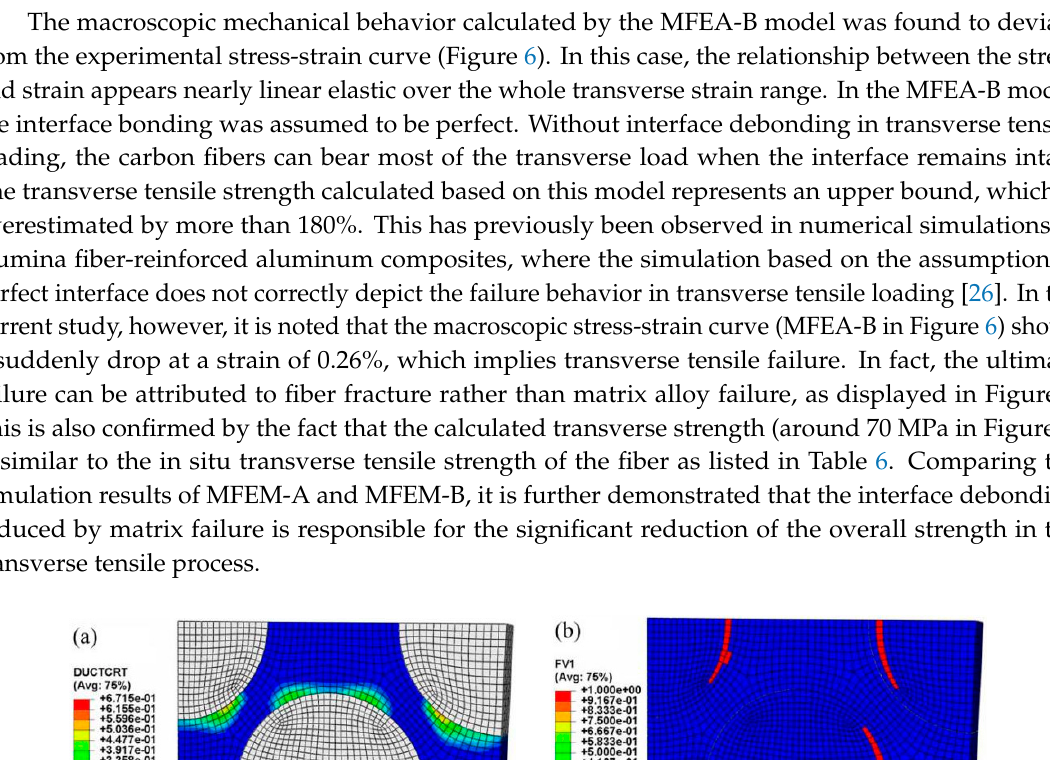
Figure 8. Fracture morphology of the composites subjected to transverse tensile loading.